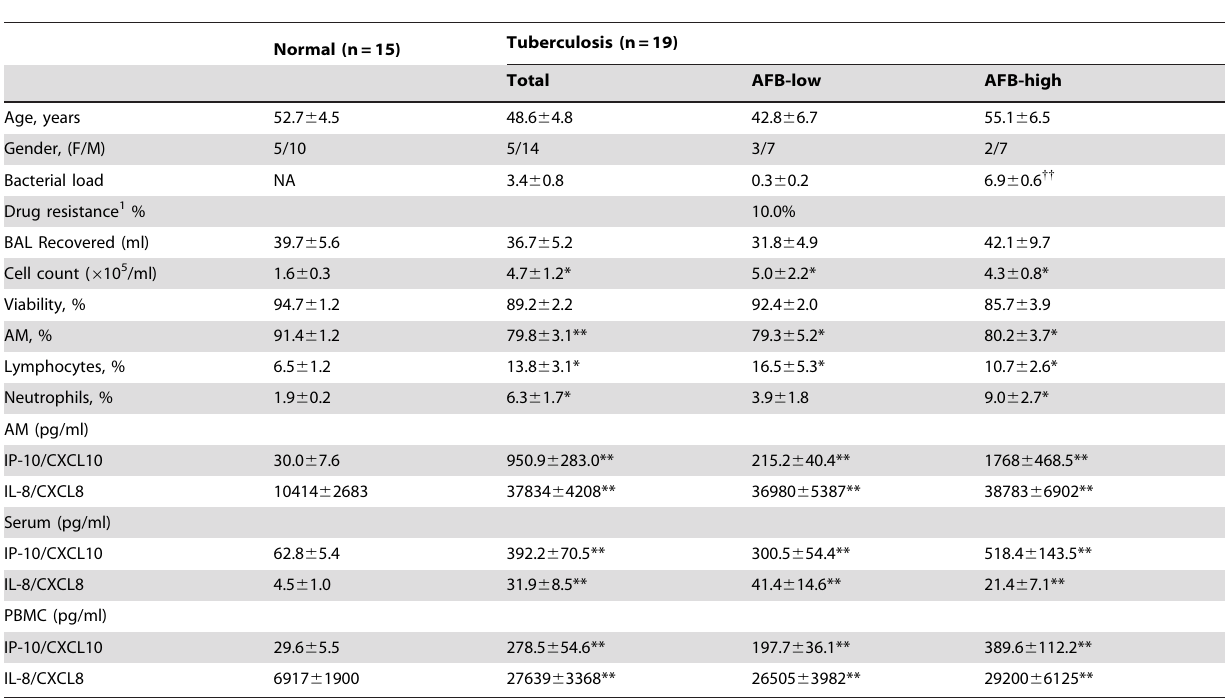
Table 1. Characteristics of normal subjects and patients with active pulmonary